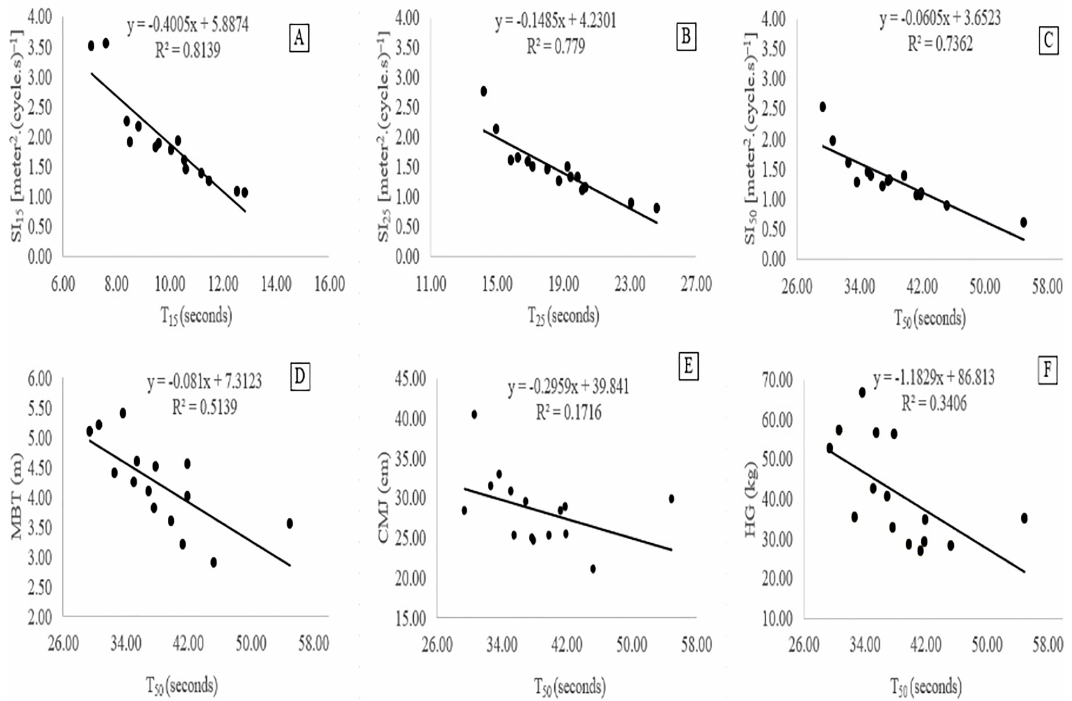
Fig. 2. Linear regression of stroke kinematics, dry-land power, and swimming sprints performance. Stroke index and the corre- spondent front crawl swimming performance time in 15, 25 and 50 m (panels A, B and C); 50 m front crawl swimming performance time linear relationship to power variables 3 kg medicine ball throwing (panel D), countermovement jump (panel E) and handgrip strength (panel F). All information in related to